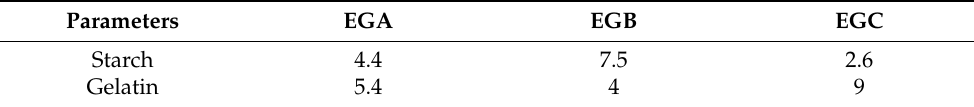
Table 5. pH adjustment values to prepare EGA, EGB and EGC. Parameters